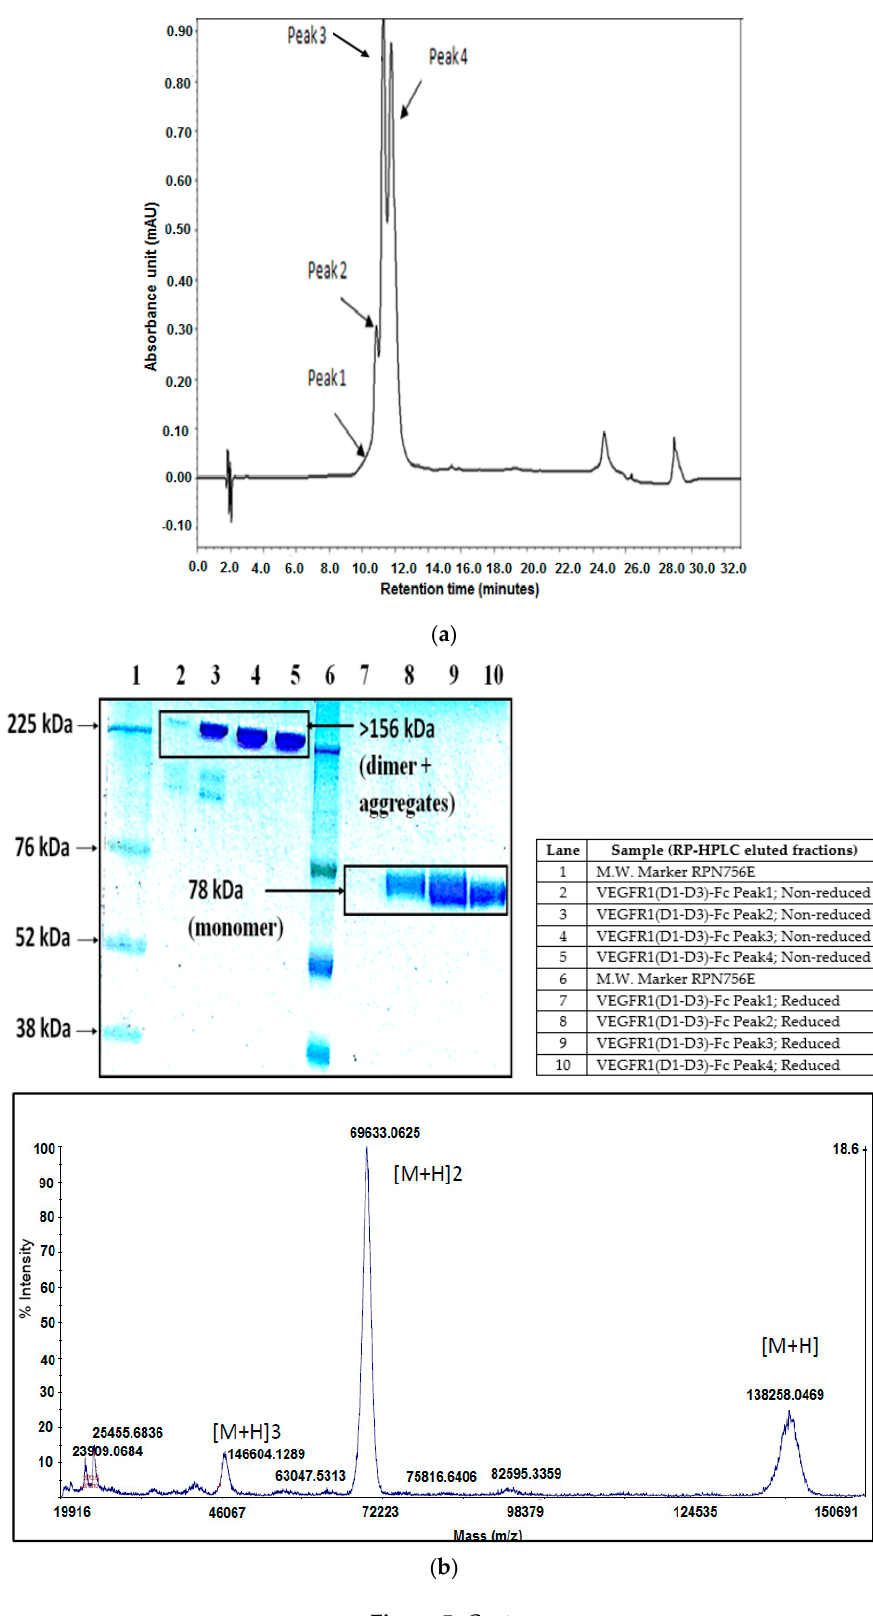
Figure 5. Cont. Figure 5.